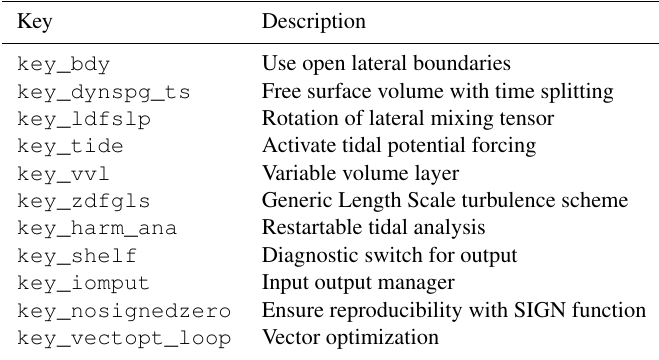
Table 2. Compilation keys for AMM15